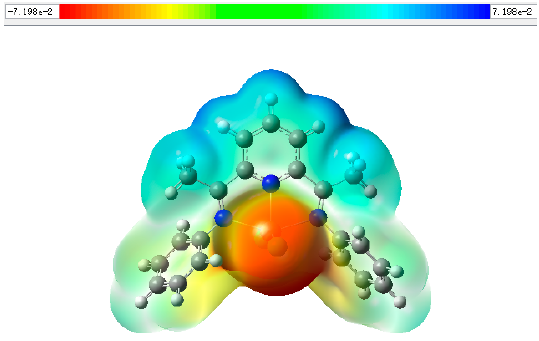
Figure 4. The electrostatic potential (ESP) of complex 1.